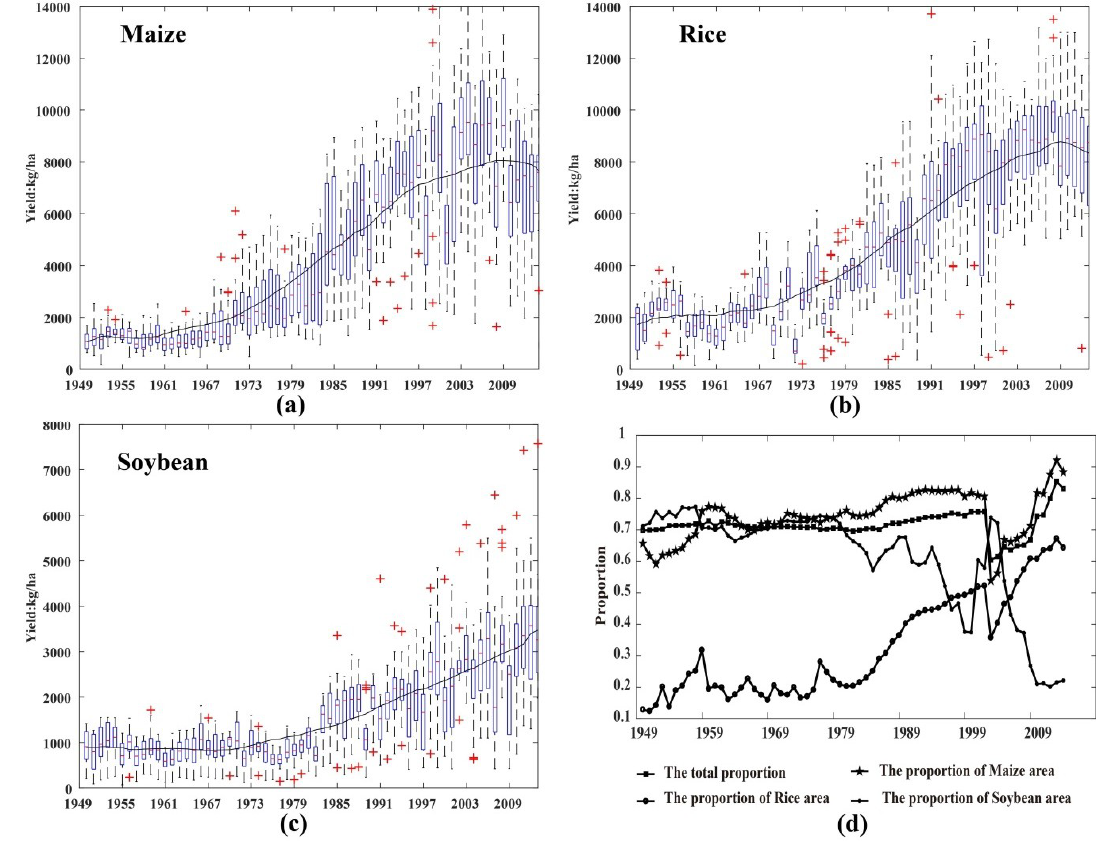
Figure 2. Temporal variations of the main types of crops in the MJP. ( a ) variation characteristics of maize yield; ( b ) variation characteristics of rice yield; ( c ) variation characteristics of soybean yield; ( d ) the proportions of individual crops area.